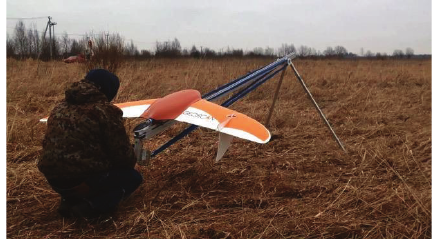
Figure 1: Launching UAV from catapult.